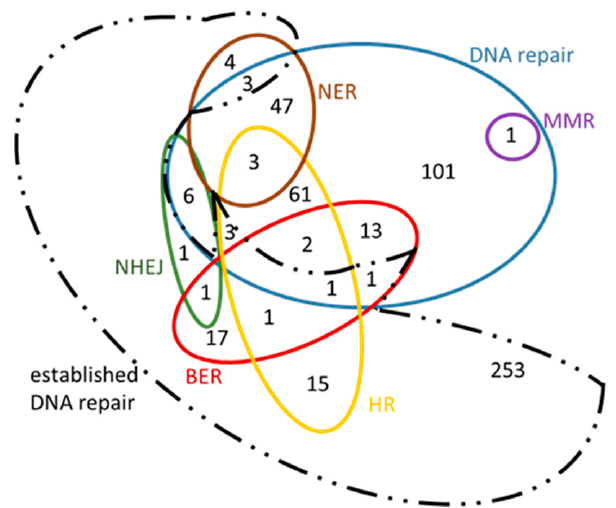
Figure 9. Venn diagram of Arabidopsis thaliana genes in their ‘new roles’. This diagram also contains the intersection with established DNA repair genes in order to highlight the great number of genes emerged from this analysis that have not been previously characterized under the inclusive term ‘DNA repair’ (dashed black line).